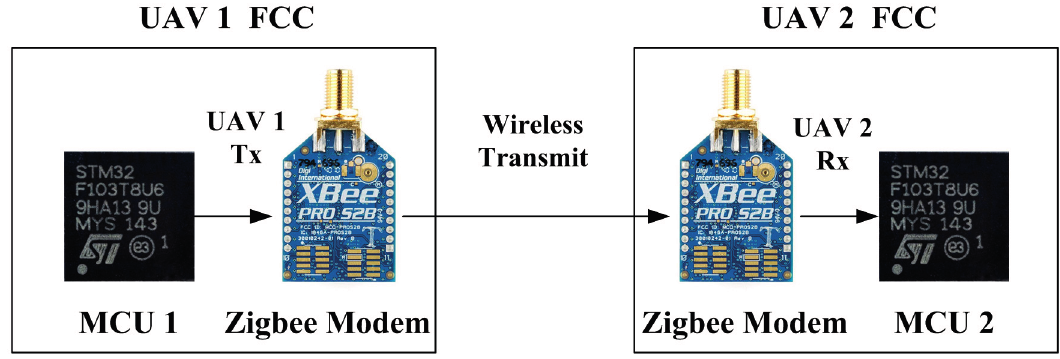
Figure 5. Communication flow for multiple